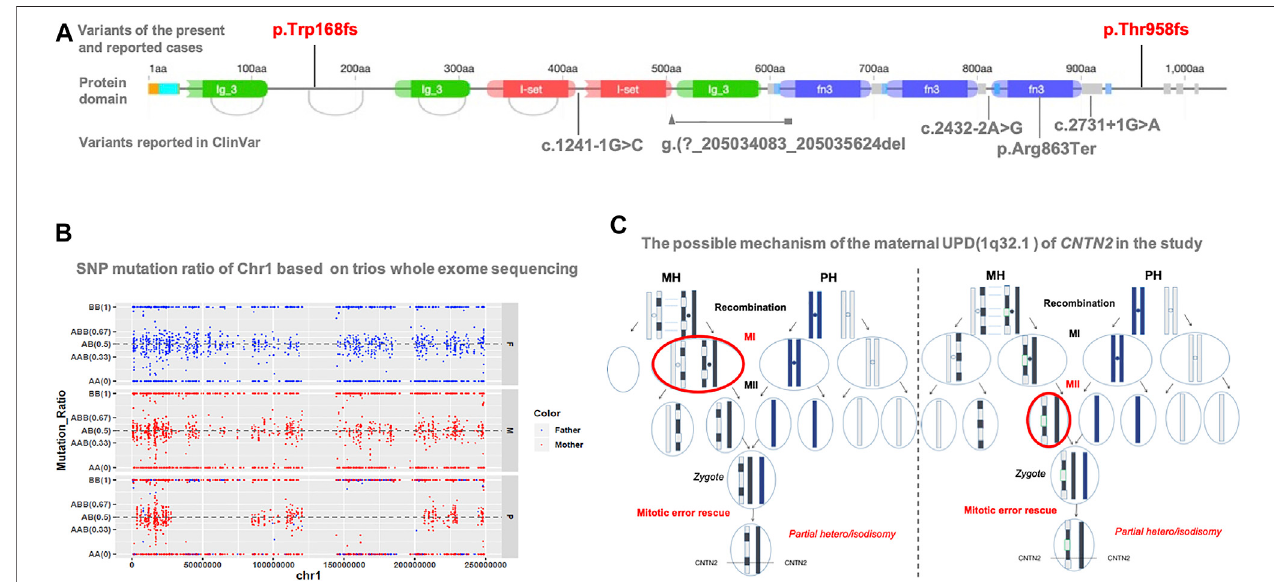
FIGURE 2 | ( A )ProteinstructureofCNTN2andlocalizationofvariantsreportedinthepresentstudy, previousliterature(red),and ClinVar database(gray).Thispresent variant (red: c.2873_c.2874delCT, p.T958Tfs*17) is in the second last exon but within the last 50aa. There is only one publication (NM_005076.5: c.504del, p.Trp168fs) reported with FAME5. Another fi ve reported loss-of-function variants in ClinVar lack detailed clinical information. The origin graph of proteindomain iscited from DECIPHER (https://www.deciphergenomics.org/). (B) SNP analysis reveals the altered regions on chromosome 1, including maternal heterodisomy at chr1: 1-26488019, chr1: 79411951-150123132, and chr1:206230986-249250621; and maternal isodisomy at chr1: 26488019-49511248, chr1: 50957509-79411951, and chr1: 150123132- 206230986 ( C ) Based on the results of SNP analysis, the possible mechanism that results in the mixture pattern of uniparental disomy (UPD) is recombination of maternal homologs(MH)beforeMeiosisI,thenLEFT:chromosomesegregationerroratMeiosisI(MI),orRIGHT:chromosomesegregationerroratMeiosisII(MII),andthenarescuing segregation error in the zygote. For simplicity, we only show the chromatid of chromosome pair for UPD with partial hetero/isodisomy. Paternal homologs